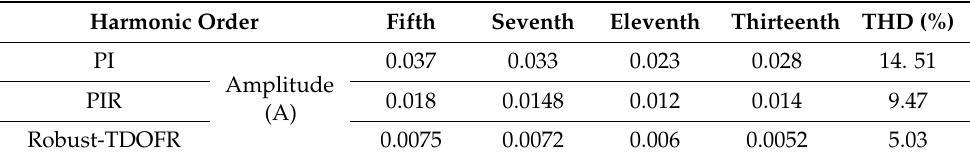
Figure 17. Phase current and FFT analysis results: ( a ) with a PI controller, ( b ) with a PIR controller and ( c ) with a Robust-TDOFR controller. Table 5. Experimental results under the operation of load.